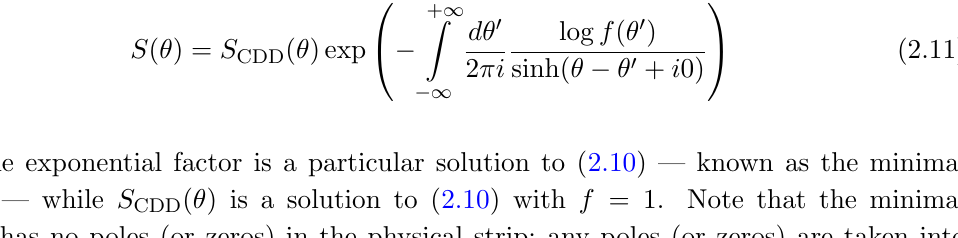
[0 ; (cid:25) ] with s = 0 ( s = 4 m 2 ) mapping 2